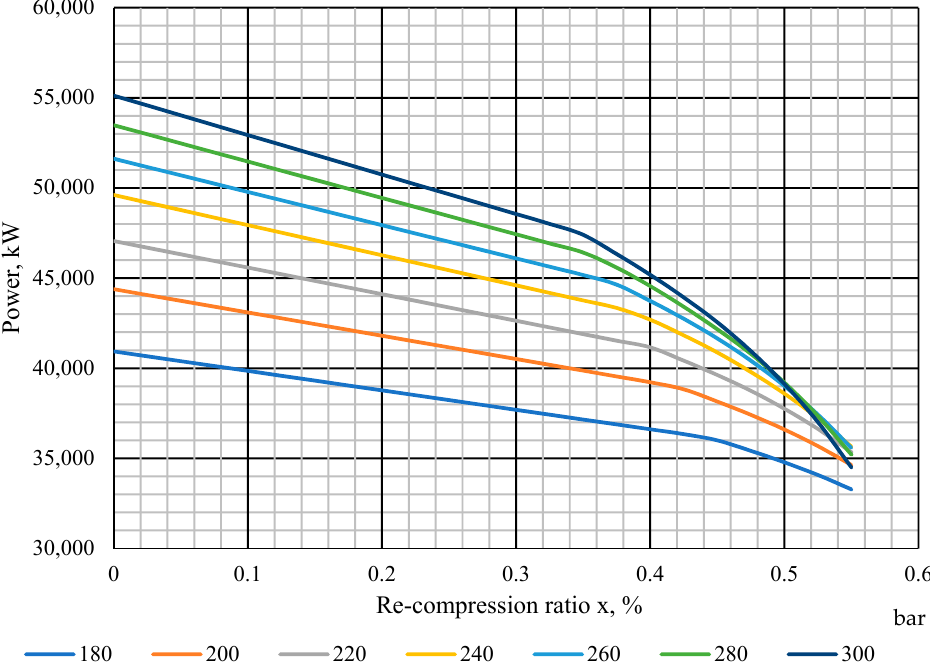
Figure 8. Dependence of cycle power on recompression ratio and turbine inlet pressure.